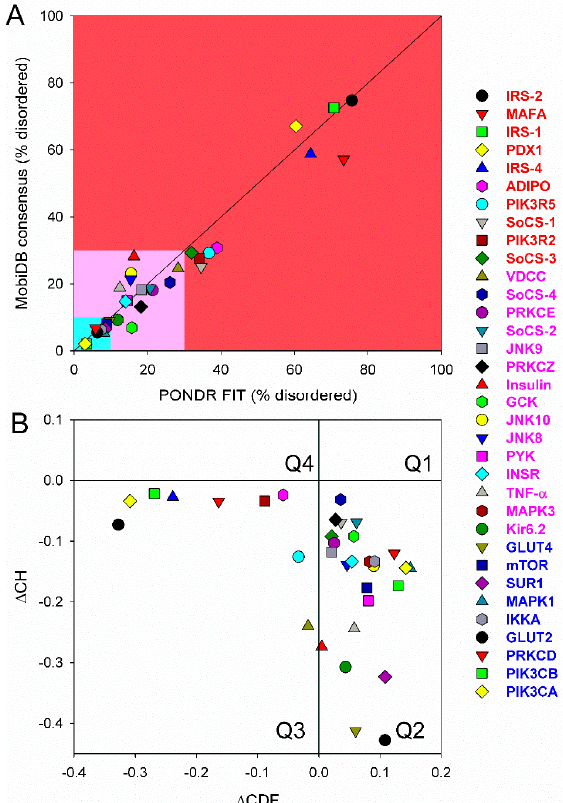
Figure 2. ( A ) Abundance of intrinsic disorder in human T2DM-related proteins. Consensus MobiDB vs. PONDR ® FIT plot representing the correlation between the disorder content evaluated by PONDR ® FIT (X-axis) and by consensus MobiDB (Y-axis). Solid black line corresponds to the diagonal. Following the accepted practice, two arbitrary cutoffs for the levels of intrinsic disorder are used to classify proteins as highly ordered (PIDRe < 10% light blue field), moderately disordered (10% ≤ PIDR < 30%, light pink field) and highly disordered (PIDR ≥ 30%, light red field) [28]. ( B ) Evaluating intrinsic disorder in human T2DM-related proteins by combined binary disorder classifiers, CH-plot [30], and CDF [30–32]. Here, the coordinates of each point were calculated as a distance of the corresponding protein in the CH-plot from the boundary (Y-coordinate) and an average distance of the respective CDF curve from the CDF boundary (X-coordinate). The four quadrants correspond to the following predictions: Q1, proteins predicted to be disordered by CH-plots, but ordered by CDFs; Q2, ordered proteins; Q3, proteins predicted to be disordered by CDFs, but compact by CH-plots (i.e., putative molten globules or hybrid proteins); Q4, proteins predicted to be disordered by both